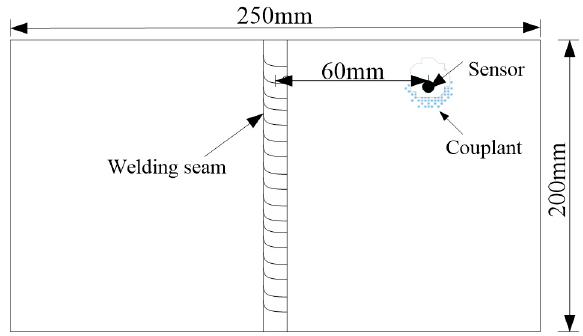
Figure 11. The arranged sensor position.